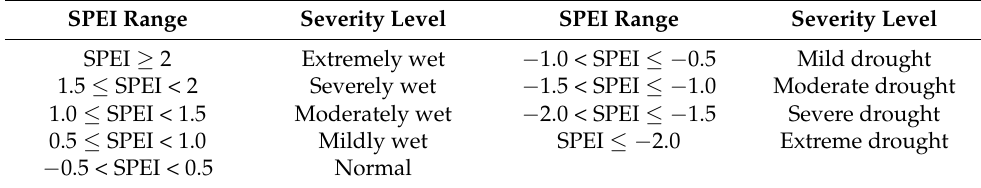
Table 2. Wet/dry severity level classified by SPEI